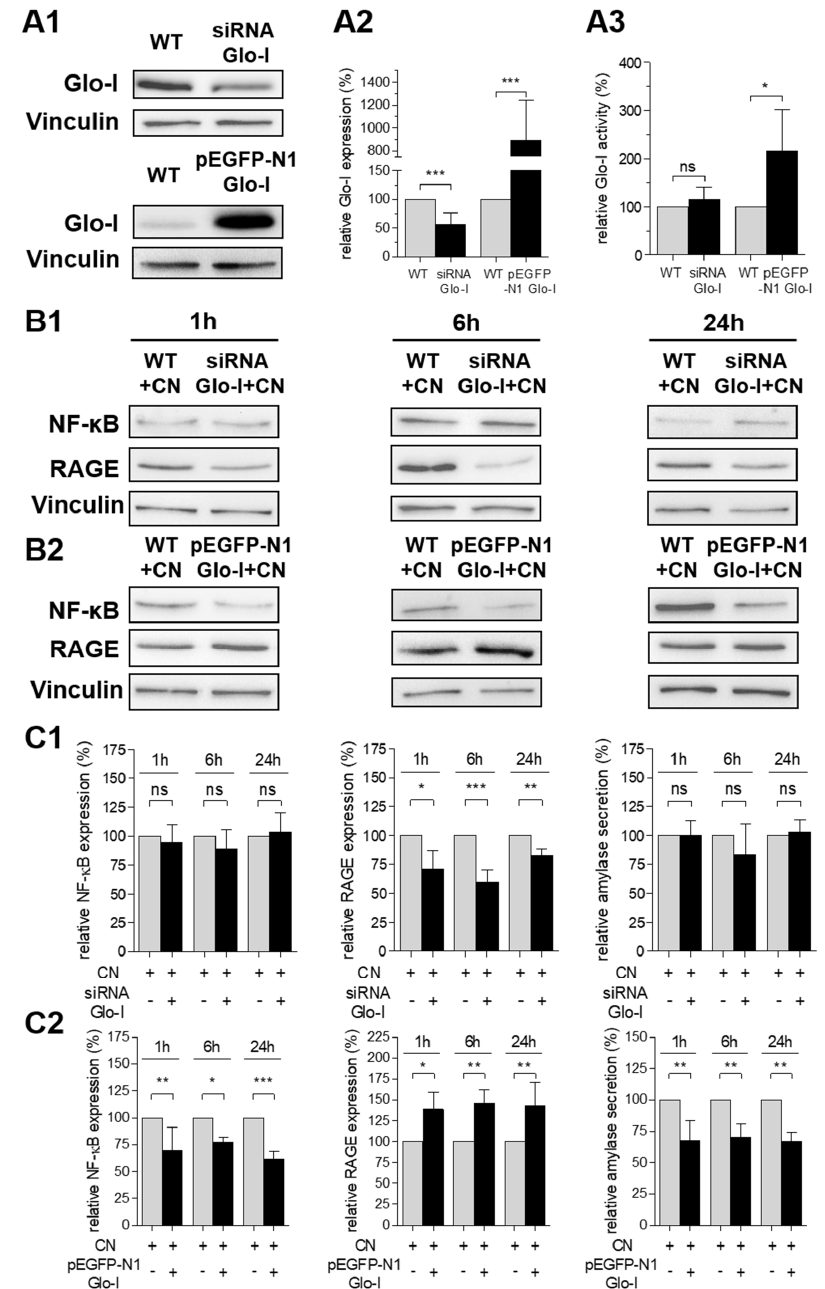
. Figure 5. Effect of Glo-I knockdown and overexpression on AR42J. ( A1 – A3 ) Western blot analysis indicated a significant Figure 5. Effect of Glo ‐ I knockdown and overexpression on AR42J. ( A1 – A3 ) Western blot analysis Glo-I knockdown in Glo-I siRNA-treated cells and a significant Glo-I overexpression in pEGFP-N1-Glo-I-treated cells. indicated a significant Glo ‐ I knockdown in Glo ‐ I siRNA ‐ treated cells and a significant Glo ‐ I overex ‐ pression in pEGFP ‐ N1 ‐ Glo ‐ I ‐ treated cells. Representative images are shown in ( A1 ), and quantifi ‐ Representative images are shown in ( A1 ), and quantifications in ( A2 ). Measurement of specific Glo-I activity ( A3 ) revealed cations in ( A2 ). Measurement of specific Glo ‐ I activity ( A3 ) revealed significant increases of enzyme significant increases of enzyme activity in Glo-I-overexpressing cells but no alterations in Glo-I siRNA-treated AR42J. ( B1 , B2 ) Representative Western blot images of NF- κ B, RAGE and Vinculin (housekeeping) in non-transfected and Glo-I siRNA transfected ( B1 ) or pEGFP-N1-Glo-I transfected ( B2 ) cells. AR42J were pretreated with dexa and then transfected for 24 h prior to CN stimulation. Cells were incubated for 1, 6 and 24 h with CN. ( C1 , C2 ) Quantifications of B1 ( C1 ) and B2 ( C2 ) confirmed a significant decrease of RAGE in siRNA-treated cells and a significant increase of RAGE, as well as decrease of NF- κ B and amylase secretion in pEGFP-N1-Glo-I transfected cells. Quantifications were calculated of at least three independent experiments and are expressed as mean ± SD. * p < 0.05, ** p < 0.01, *** p < 0.001. CN: cerulein, Glo-I: glyoxalase-I, RAGE: receptor of advanced glycation